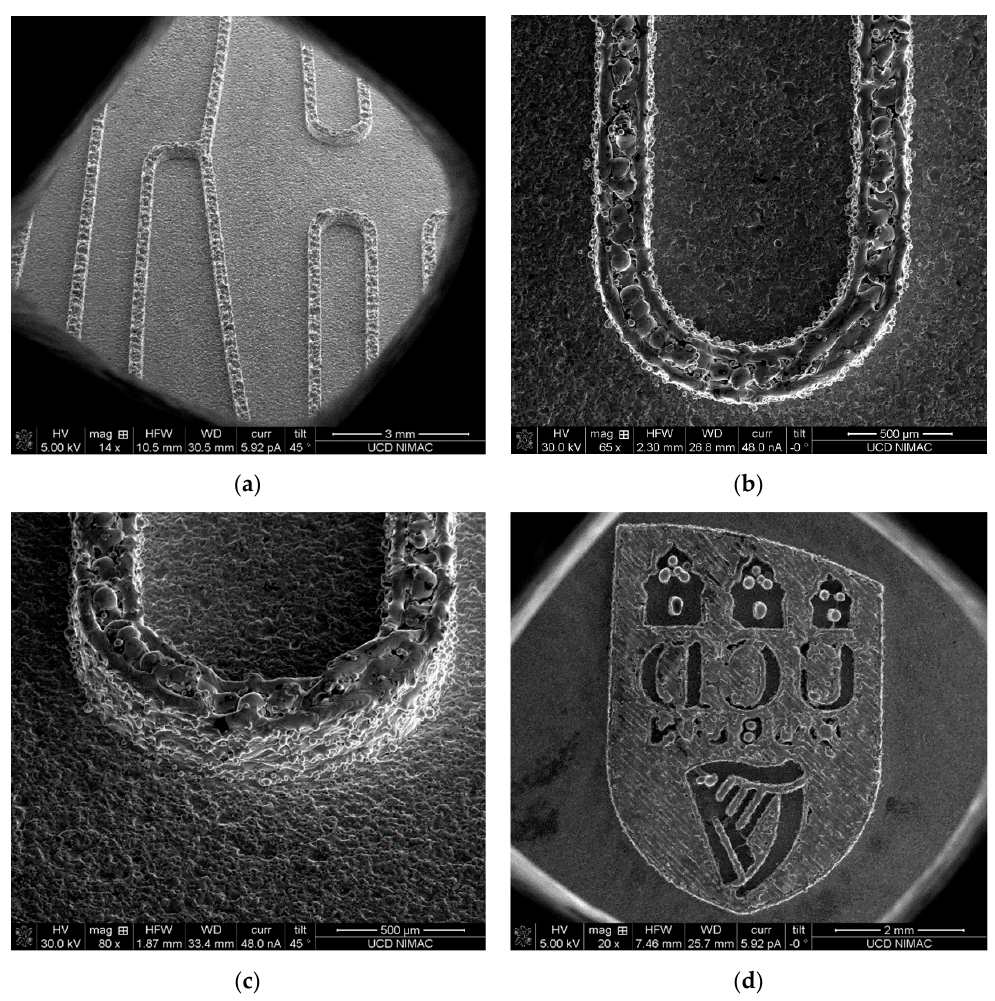
Figure 6. 3D printed microfluidic inverted pattern based on SLM: ( a ) inverted channel overview, ( b ) inverted U channel overview, ( c ) tilt view of U channel and ( d ) UCD crest printed from SLM process.